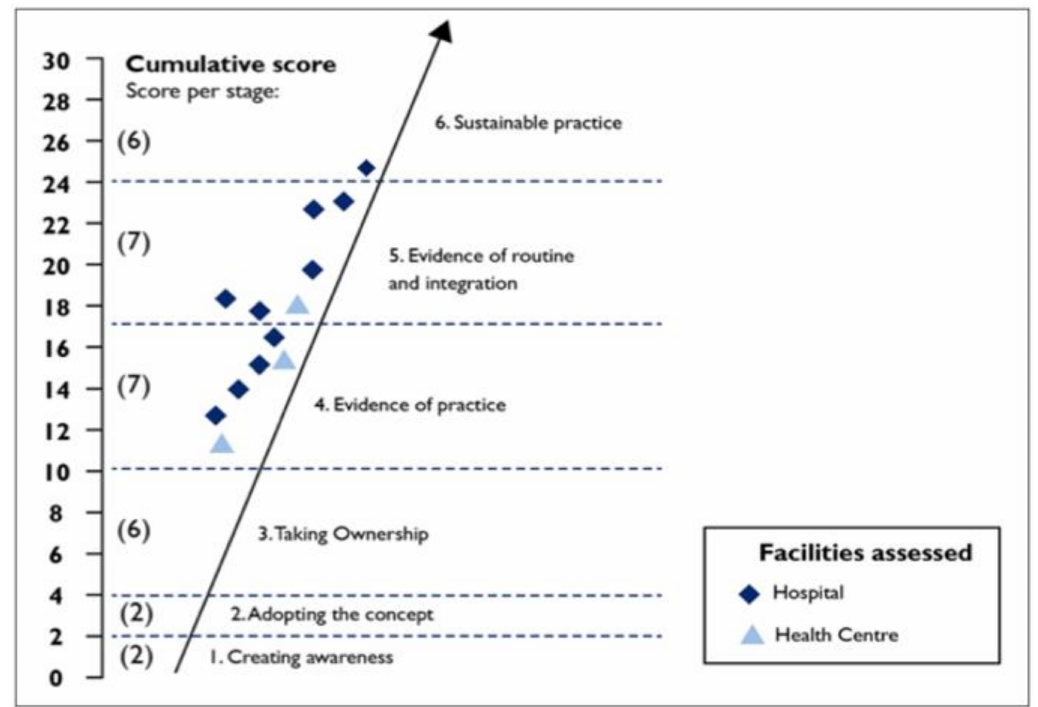
Figure 1. Facility score and stage of